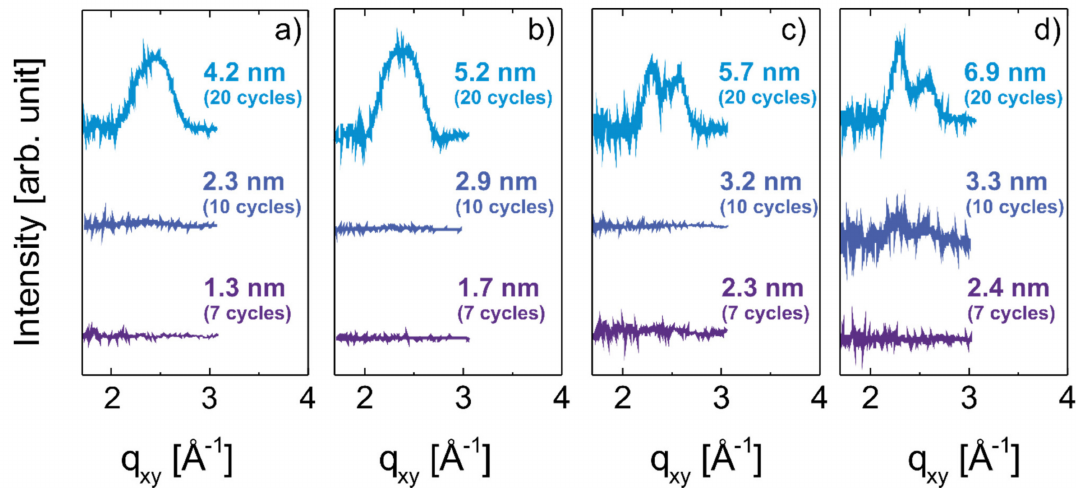
Figure 8. GIXD intensity as a function of q for ZnO layers of di ff erent thickness (7, 10, and 20 cycles) and deposited at di ff erent temperatures: ( a ) 50 ◦ C, ( b ) 100 ◦ C, ( c ) 150 ◦ C, and ( d ) 200 ◦ C. Irrespective of deposition temperature and preferred orientation (100 or 002), the crystallinity develops at above 3